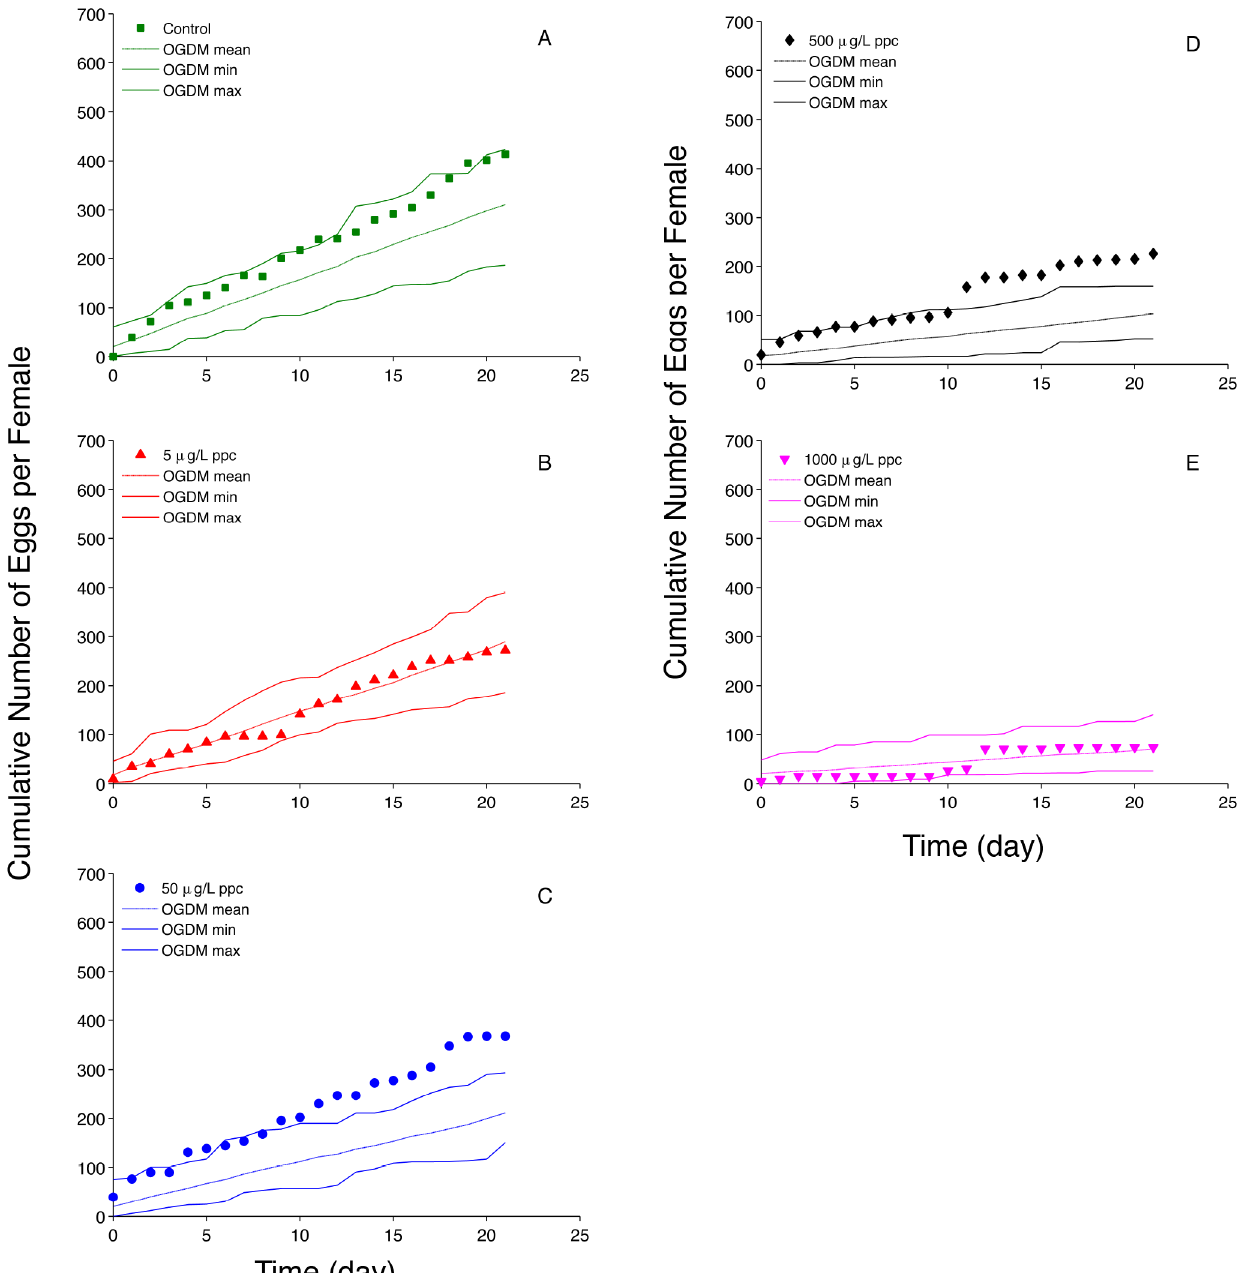
Fig 8. Propiconazole (ppc) Average Cumulative Fecundity. (A) control (0 μ g ppc (cid:129) L -1 ); (B) 5 μ g ppc (cid:129) L -1 ; (C) 50 μ g ppc (cid:129) L -1 ; (D) 500 μ g ppc (cid:129) L -1 ; and (E) 1000 μ g ppc (cid:129) L -1 . Filled markers represent experimental data (cumulative fecundity divided by the number of females in a treatment group) obtained from figures in Skolness et al. [13]; dashed lines represent the mean of 50 cumulative fecundity OGDM predictions; solid lines represent the minimum and maximum values of individual cumulative fecundity out of 50 OGDM model